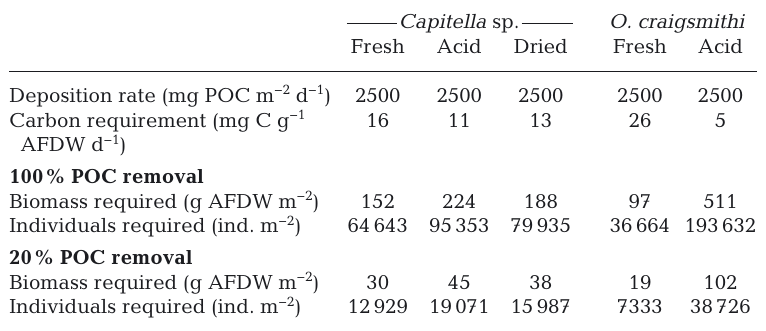
Table 5. Capitella sp. and Ophryotrocha craigsmithi biomass and number of indi- viduals required to remove 100 or 20% of the particulate organic carbon (POC) flux to the benthic system of a commercial salmon farm in Norway. Polychaete re- quirement calculated for coupled (i.e. fresh salmon waste) and decoupled systems where waste preservation is recommended (acid preservation and oven-drying). Deposition rate derived from Kutti et al. (2007a). Carbon requirements are the sum of respiration rates (this study) and tissue growth rates (based on Nederlof et al. 2019). To calculate the number of individuals required, individual geometric mean body weight of 2.35 mg AFDW for Capitella sp. and 2.64 mg AFDW for O. craigsmithi was used (based on the growth experiment in Nederlof et al.